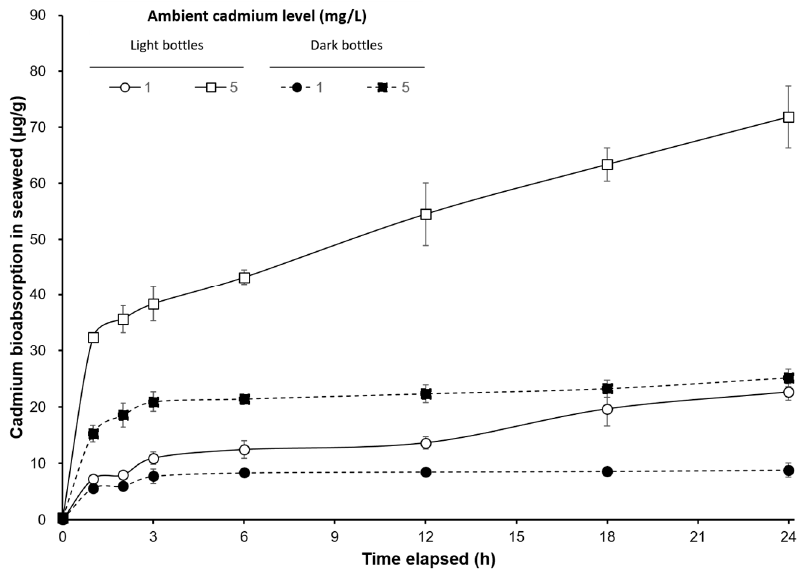
Figure 2. Time ‐ course changes of cadmium bioabsorption ( μ g/g) on S. suiae under different cadmium concentrations (1 and 5 mg/L) exposure in light and dark bottles.